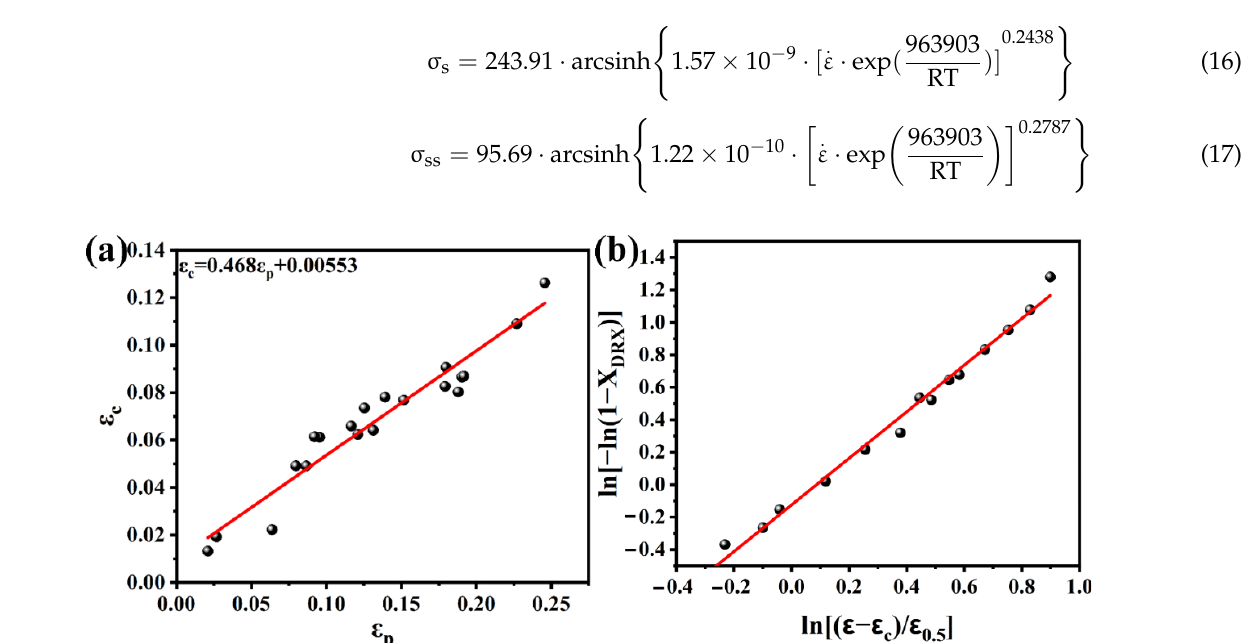
Figure 11. ( a ) T he relationship between ε c and ε p , ( b ) the relationship between ln[(ε−ε c )/ε 0.5 ] and Figure 11. ( a ) The relationship between ε c and ε p , ( b ) the relationship between ln[( ε − ε c )/ ε 0.5 ] and ln[ − ln( 1− X DRX ]. ln[ − ln(1 − X DRX